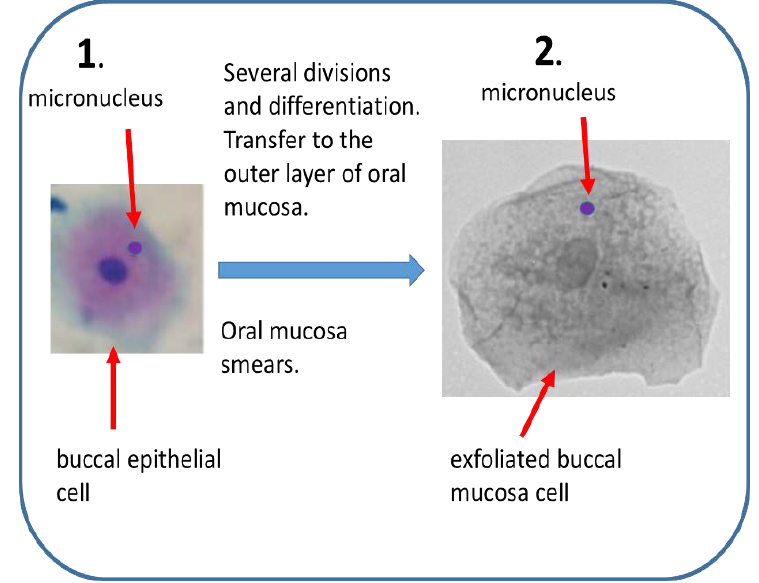
Figure 3. Buccal micronucleus assay. (1) Mn are induced in vivo by genotoxic agents in rapidly dividing buccal epithelial tissue. Epithelial cells differentiate and move towards outer layer of oral mucosa. (2) Mn frequency can be estimated in smears of exfoliated buccal cells.